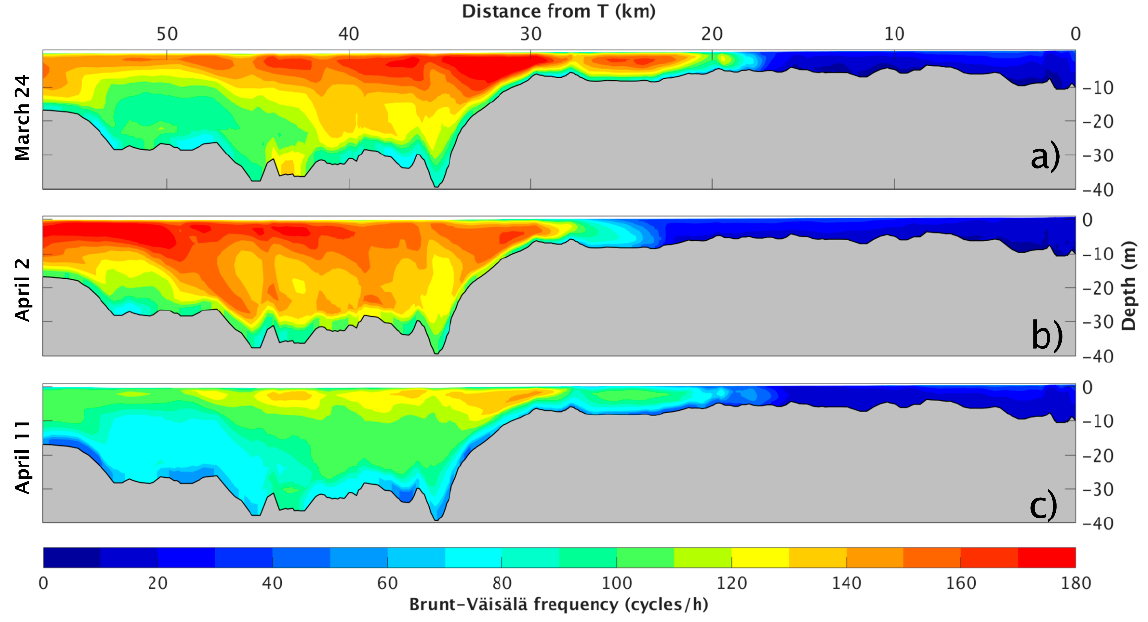
Figure 6. Daily averaged vertical profiles of Brunt–Väisälä frequency along the longitudinal section of the estuary (#ScRef); ( a ) 24 March; ( b ) 2 April; and ( c ) 11 April, before, during, and after the extreme freshwater discharge event,